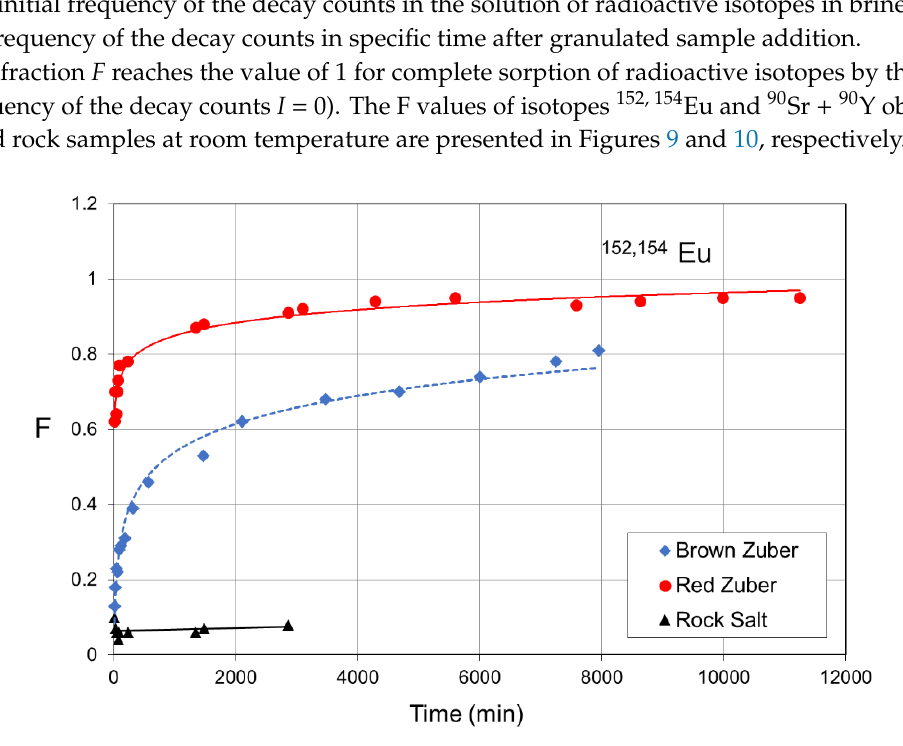
Figure 9. Sorption of the 152,154 Eu isotope of the Brown and Red Zuber unit samples and rock salt samples (according to